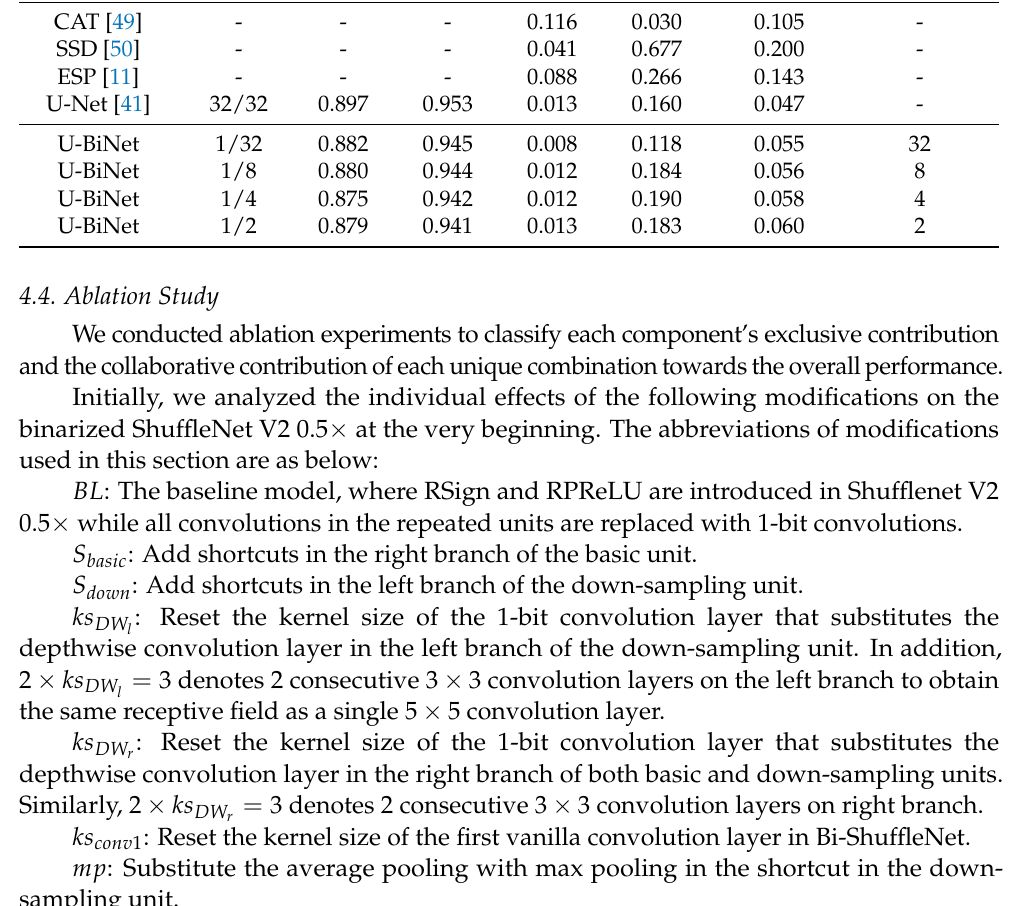
Table 4. Fined-grained defect detection performance on NEU Patches. ‘ − ’ indicates that the information was not reported or is not known to us. Method Bitwidth Dice Accuracy FPR FNR MAE